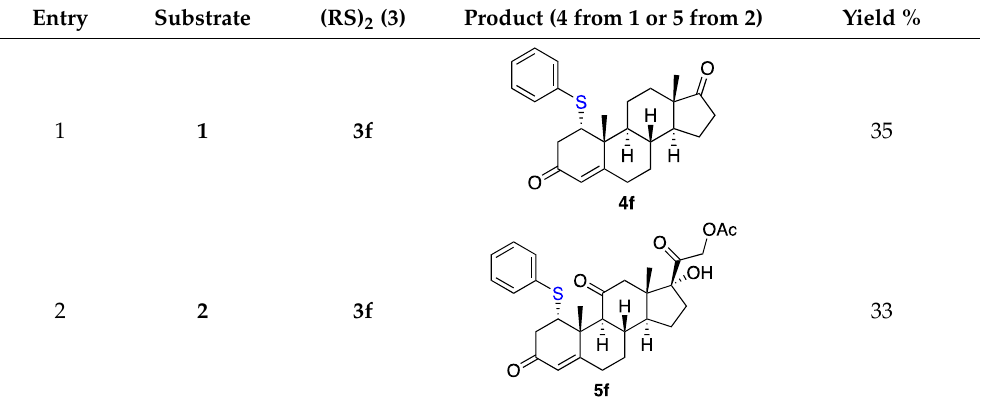
Table 3. Thio-Michael reactions.